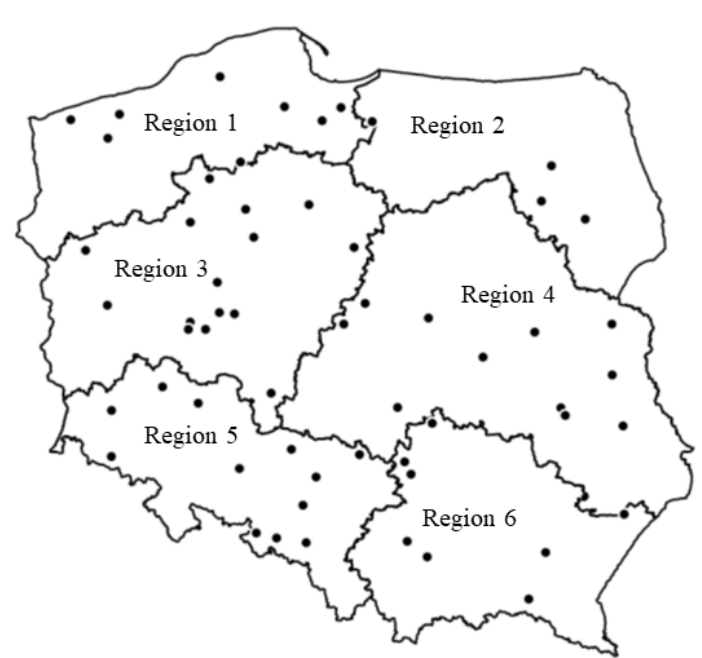
a Polish system of evaluation for soil quality—from I (best) to VI (worst).